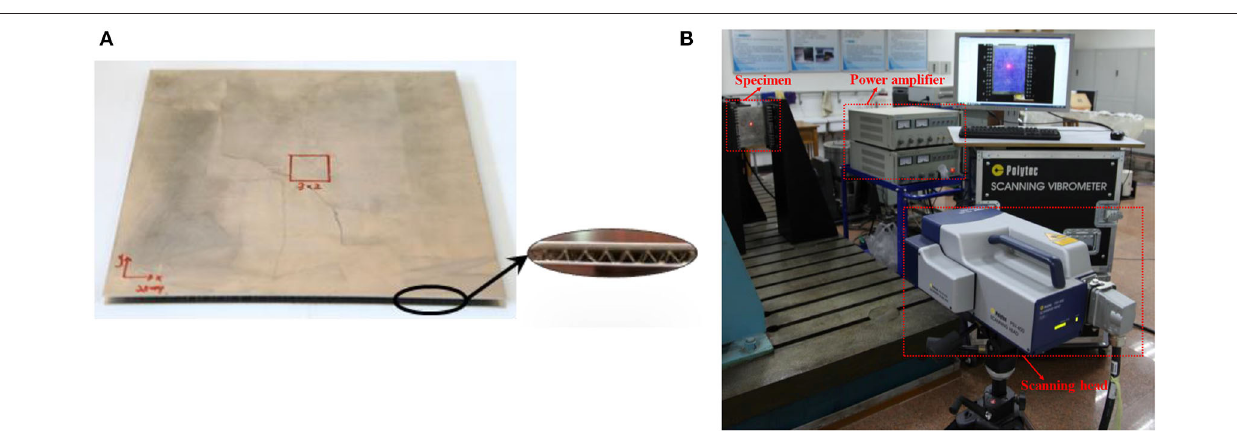
Frontiers in Materials |